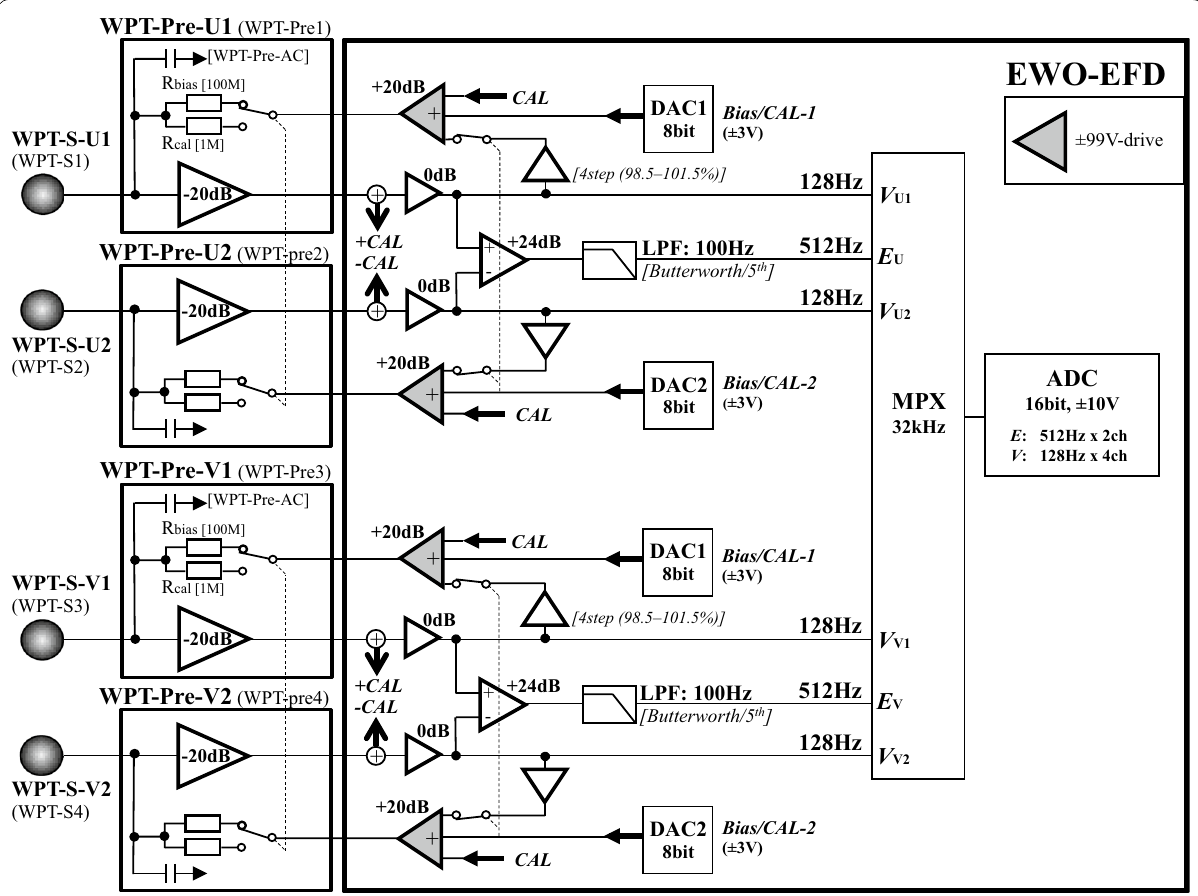
Fig. 5 Block diagram of